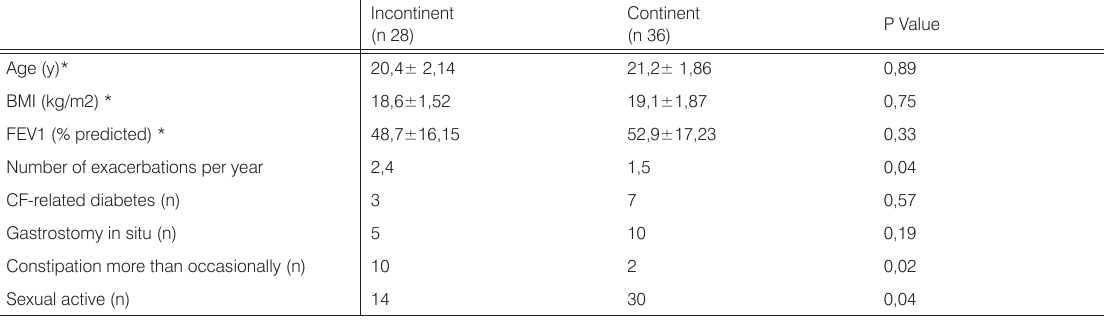
Table 1. Characteristics of Incontinent and Continent